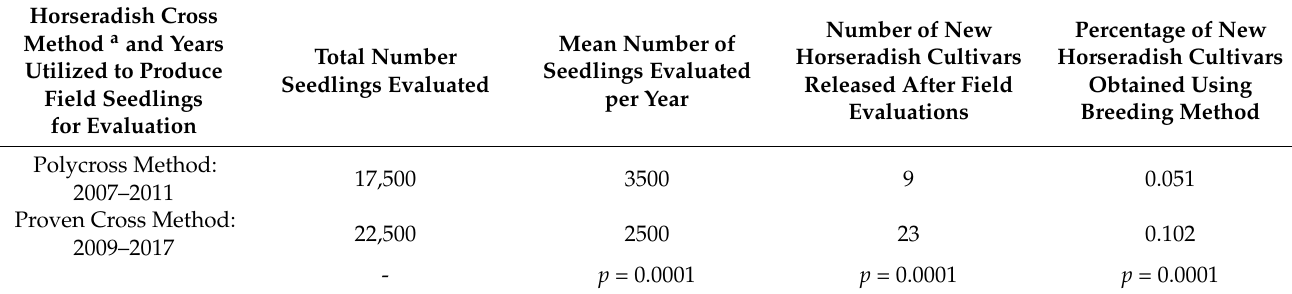
Table 1. Evaluation of horseradish breeding methods for development of new horseradish cultivars in Illinois, USA. Horseradish